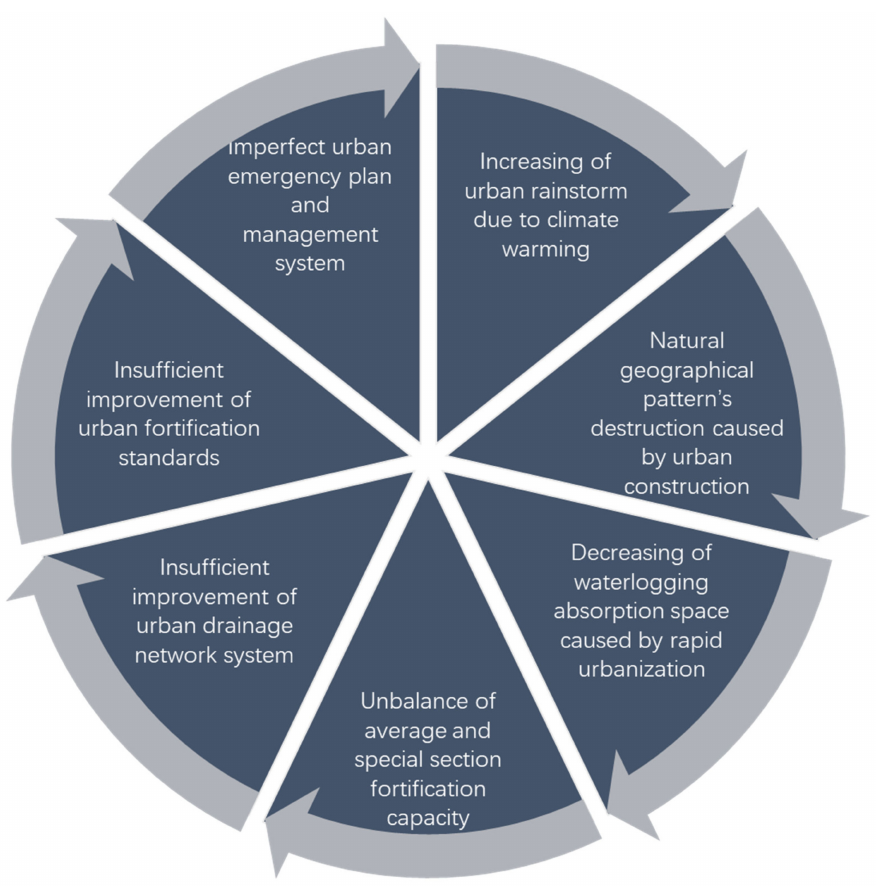
Figure 2. Diversified potential causes of urban rainstorm waterlogging in